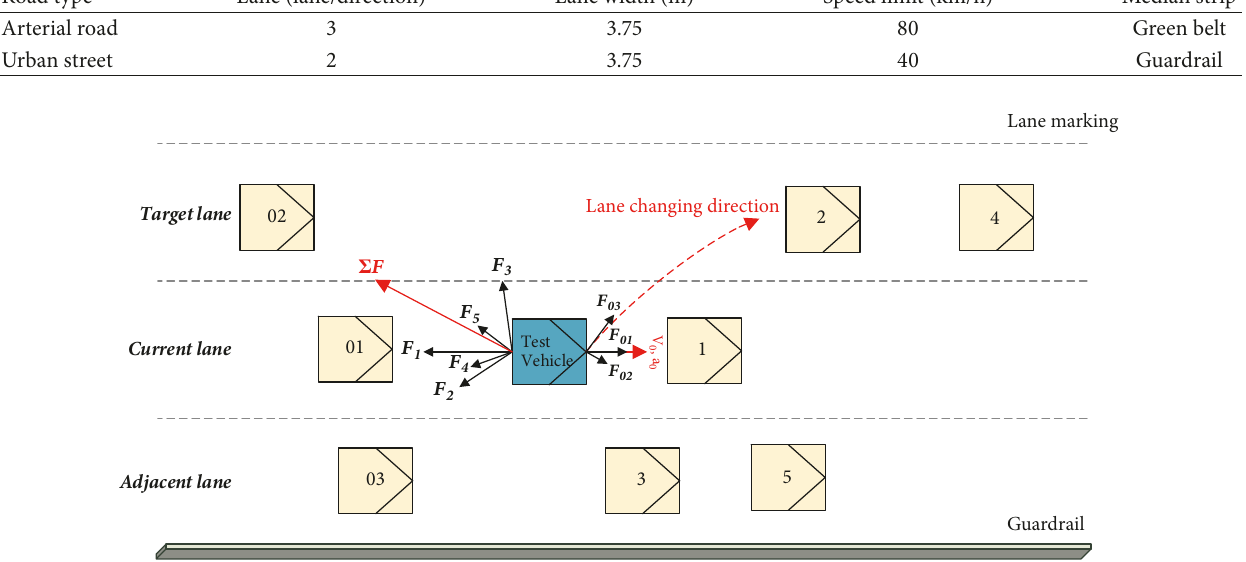
Figure 3: Impact of resultant vision pressure ( Σ𝐹 ) on vehicle.